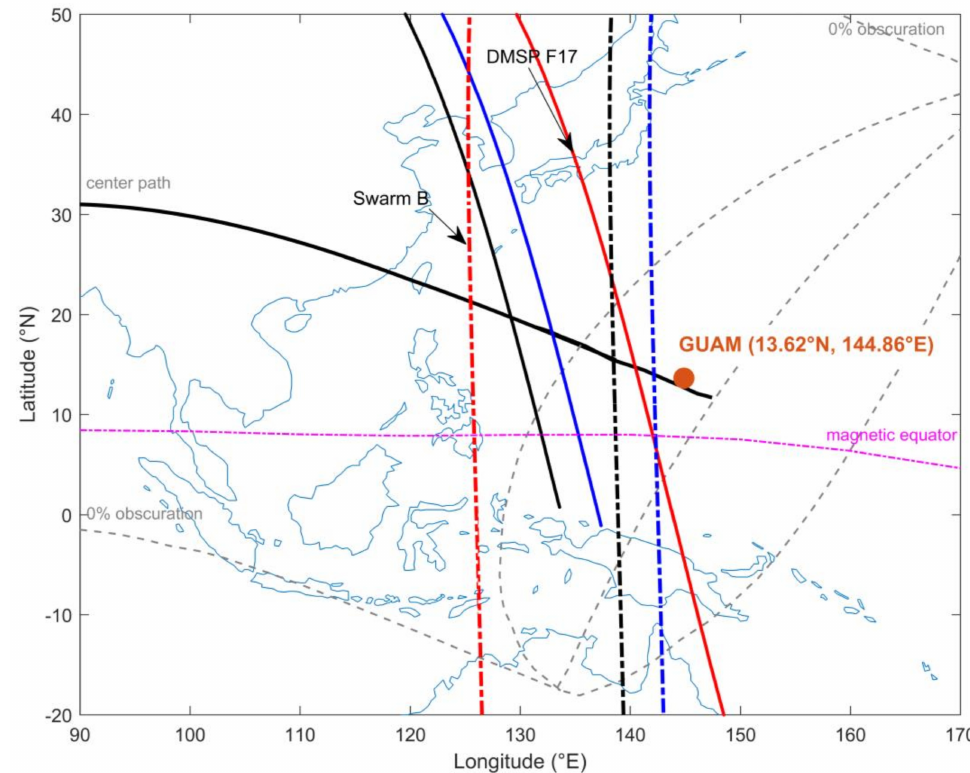
Figure 2. Locations of the ionosonde (brown circle), the ground-track of Swarm-B satellite (dotted lines), and DMSP F17 spacecraft (solid lines) paths. The red indicates the satellite tracks on the solar eclipse day (21 June 2020). The black and blue indicate the satellite tracks on 18 and 19 June 2020, respectively. The magenta line represents the magnetic equator. The gray and black curves indicate the eclipse path. The GNSS receiver at Guam used in this study is not displayed in Figure 2, because it is near the location of